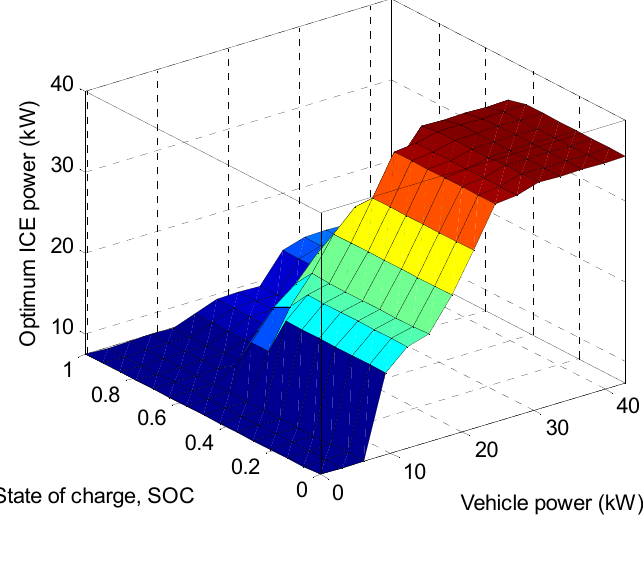
Figure 8. Surface plot of the ICE fuzzy logic